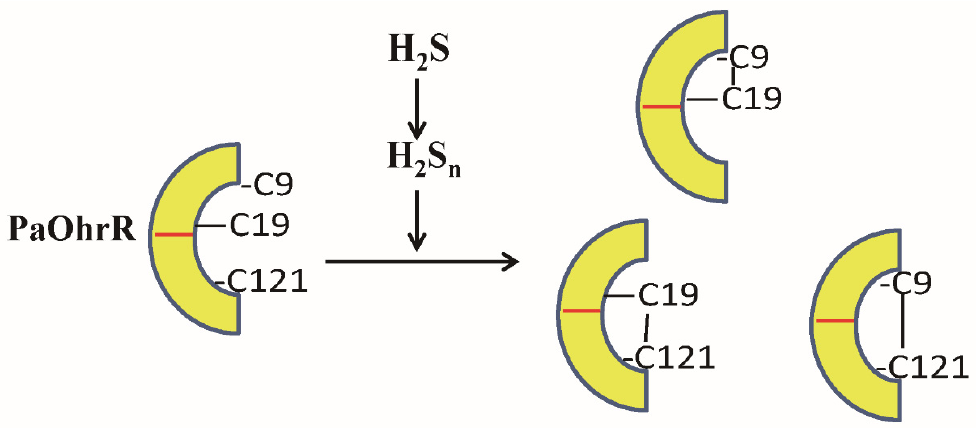
Figure 6. Schematic representations of the PaOhrR dimer that senses sulfane sulfur, forming several disulfide bonds between three key cysteine residues.